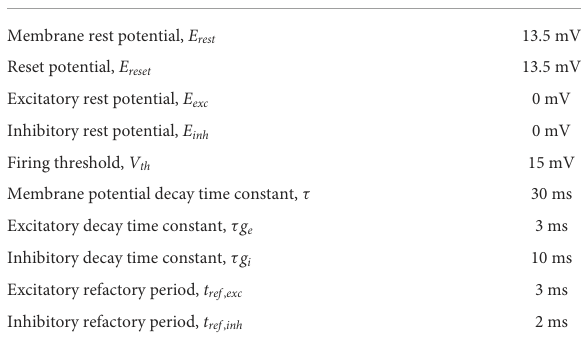
TABLE 1 Conductance-based leaky integrate-and-fire neuron model: Parameter names and corresponding